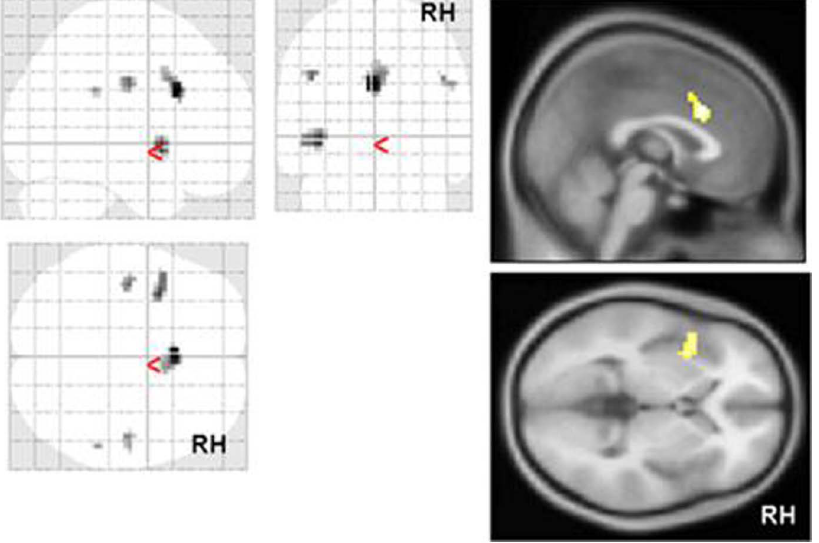
Figure 2. Group comparison healthy controls . schizophrenia for ironic sentences . visual baseline. p , 0.001, ext. 5 voxels. Strongest maxima in the posterior part of the anterior cingulate (ACC) and the LH anterior insula. See as well supplemental figure S1.